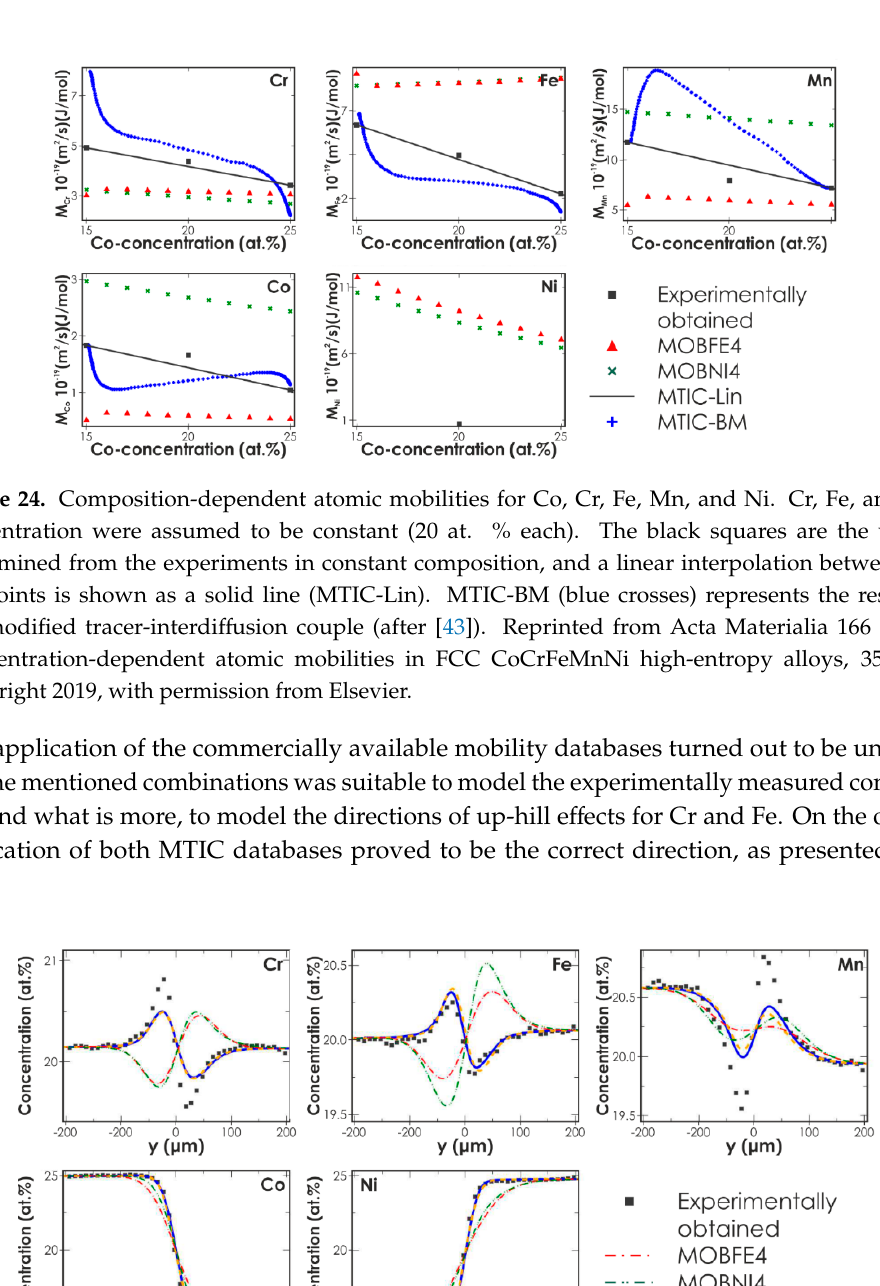
Figure 25. Comparison between experimentally obtained interdiffusion profiles and simulated ones using the HEA-DB mobility data base combined with different atomic mobility databases for all five elements (Co, Cr, Fe, Mn, and Ni) after 48 h at 1373 K (after [43]). Reprinted from Acta Materialia 166 (2019), Concentration-dependent atomic mobilities in FCC CoCrFeMnNi high-entropy alloys, 357–370, Copyright 2019, with permission from Elsevier.